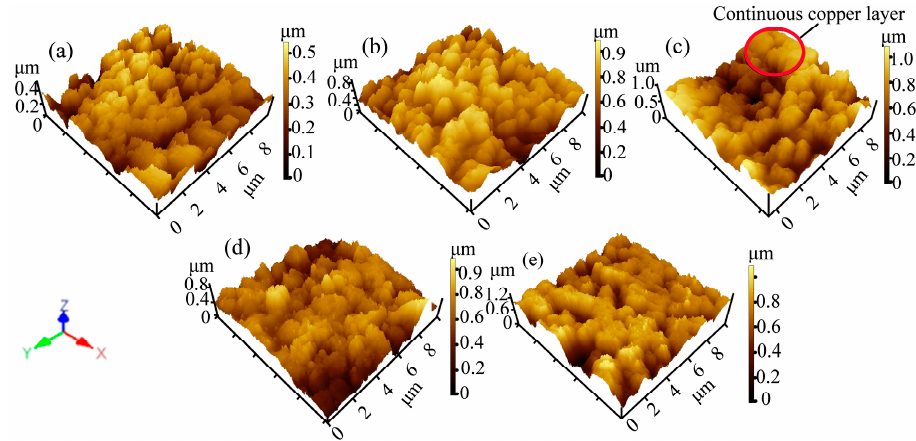
Figure 1. AFM images of the metalized membranes (10 μ m × 10 μ m) with different sputtering times: